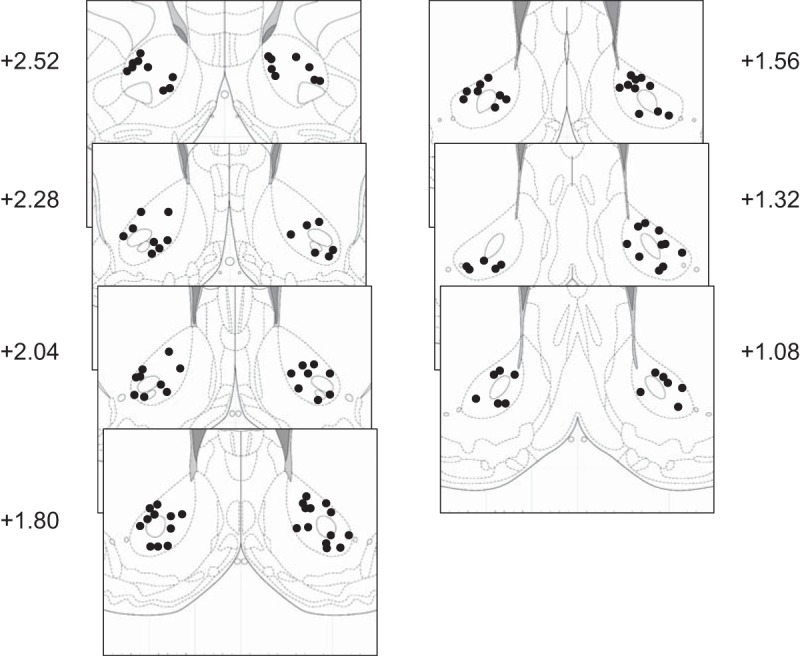
Histological reconstruction of recording locations in NAc core. Panels are coronal atlas sections (Paxinos and Watson, 2007) showing the location of electrode tips derived from electrolytic lesions and/or electrode tracks. Numbers are distance in millimeters from bregma.